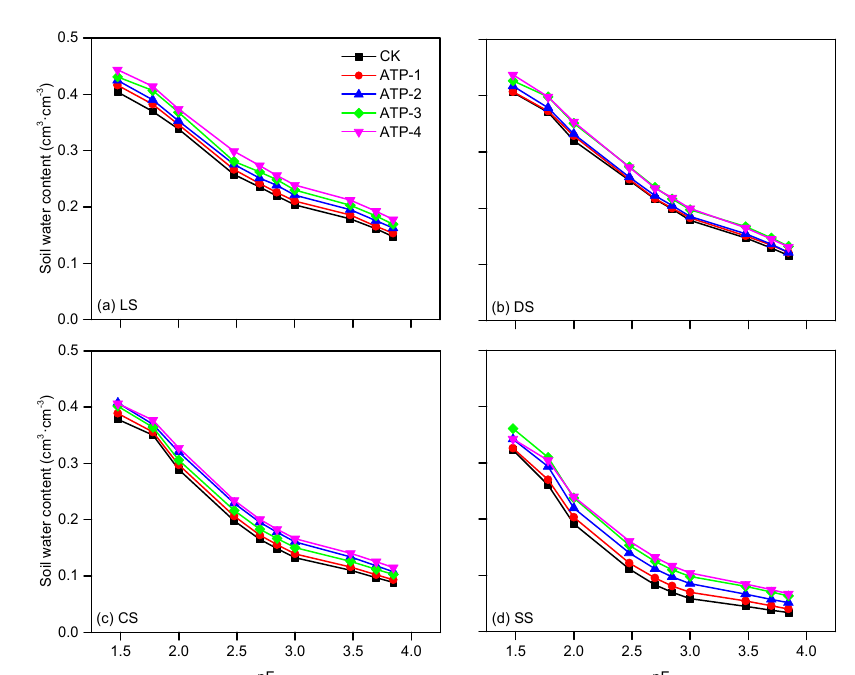
Figure 2. Soil water retention curve (SWRC) for lou soil (LS), dark loessial soil (DS), cultivated loess soil (CS), and sandy soil (SS). pF = log10|h|, where h is the pressure head (cm).